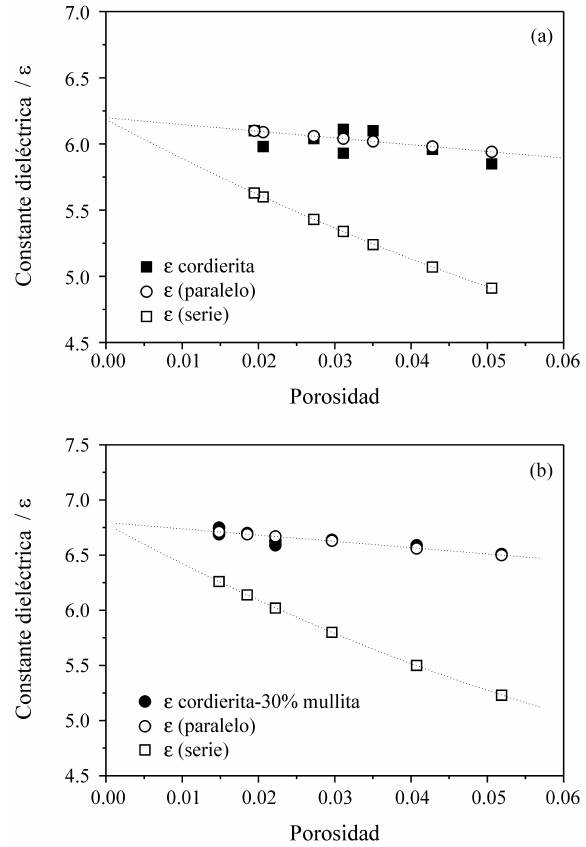
Figura 3. Efecto de la porosidad sobre ε para los materiales de (a) cordierita y (b) cordierita-30%